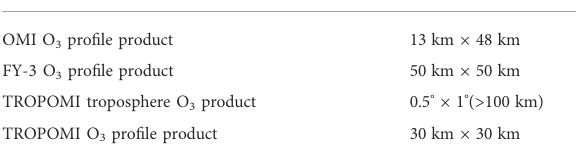
TABLE 1 Surface ozone product and its spatial resolution. OMI, ozone monitoring instrument; FY-3, Fengyun-3 satellite; and TROPOMI, TROPOspheric Monitoring